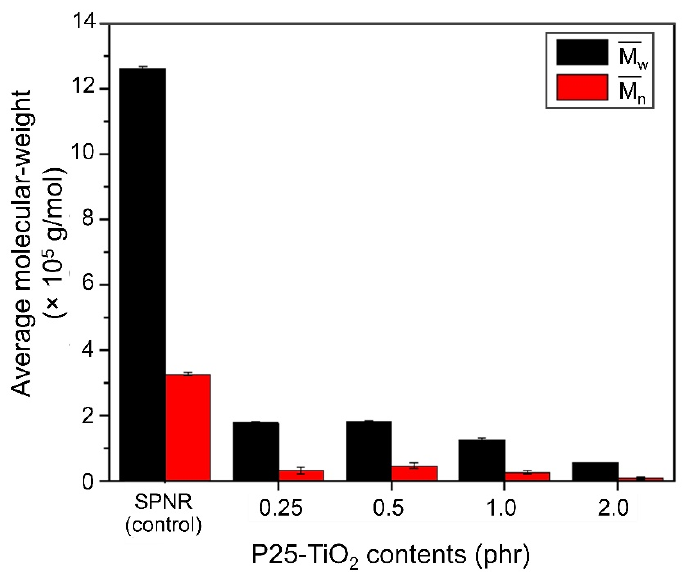
Figure 3. The average MW of SPNR and samples prepared by introducing various TiO 2 powder contents in the presence of 20% w / w H 2 O 2 after UVC-irradiation for 5 h.